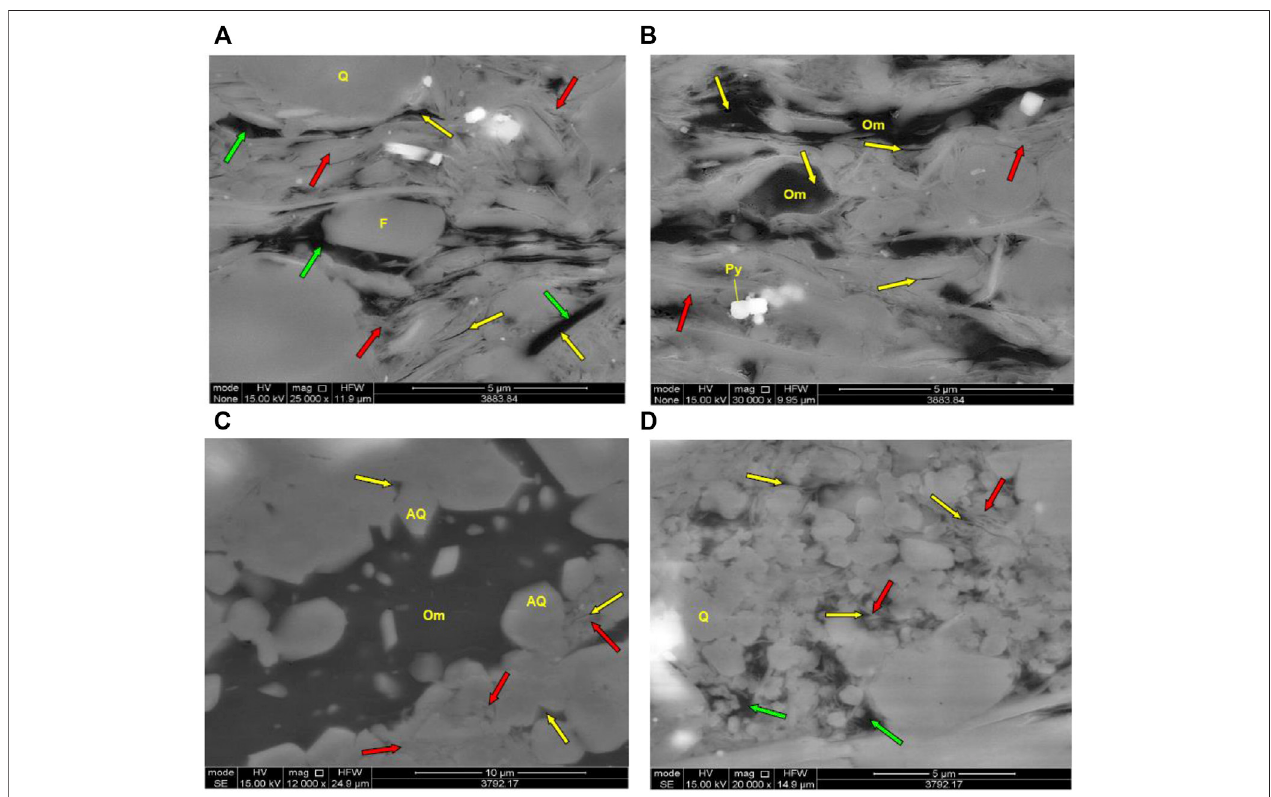
FIGURE5| TheSEMimages showingthemicrostructureoftheWufeng-LongmaxiShale: (A,B) showsthatthepores betweenclayplateletsor aroundtheedgeof rigid particles are of elongated, compliant shape; (C,D) shows that the intergranular pores, which have a rigid triangular structure, are mainly developed between the quartz